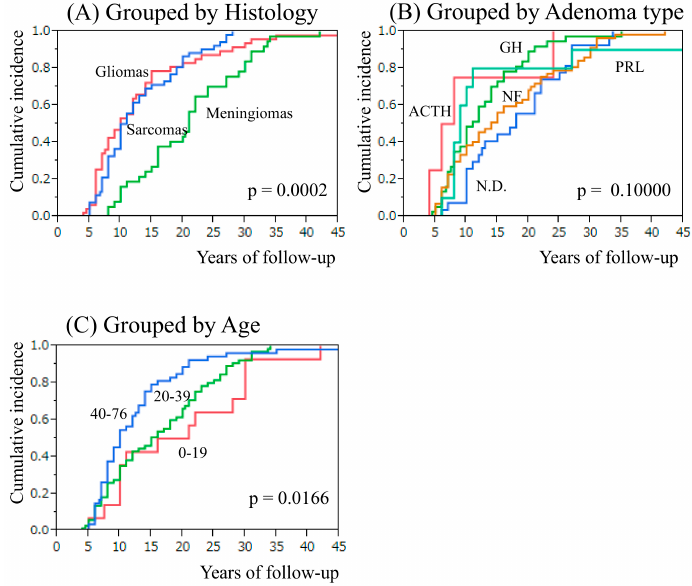
Figure 2. Latency period from pituitary adenoma to development of secondary brain tumor. ( A ) Comparing groups classified as brain tumor histology. ( B ) Comparing groups classified as pituitary adenoma type. ACTH: Cushing disease, GH: acromegaly, N.D.: not determined, NF: non-functioning adenoma, PRL: prolactinoma. ( C ) Comparing groups classified in 0–19, 20–39, 40–76 year age group.